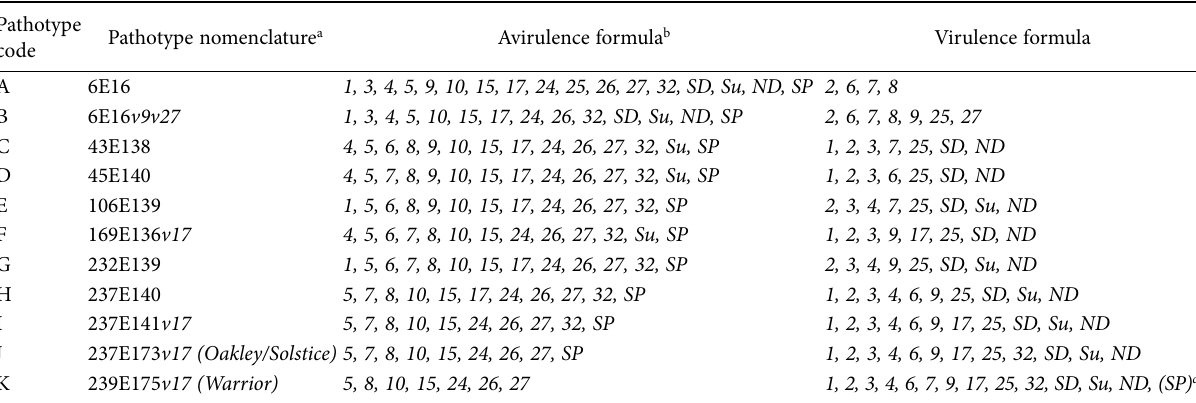
Table 1. Pathotype code, name and avirulence/virulence formula of 11 French Puccinia striiformis f. sp. tritici pathotypes used for the postu- lation of stripe rust resistance genes in Syrian and Lebanese wheat genotypes.